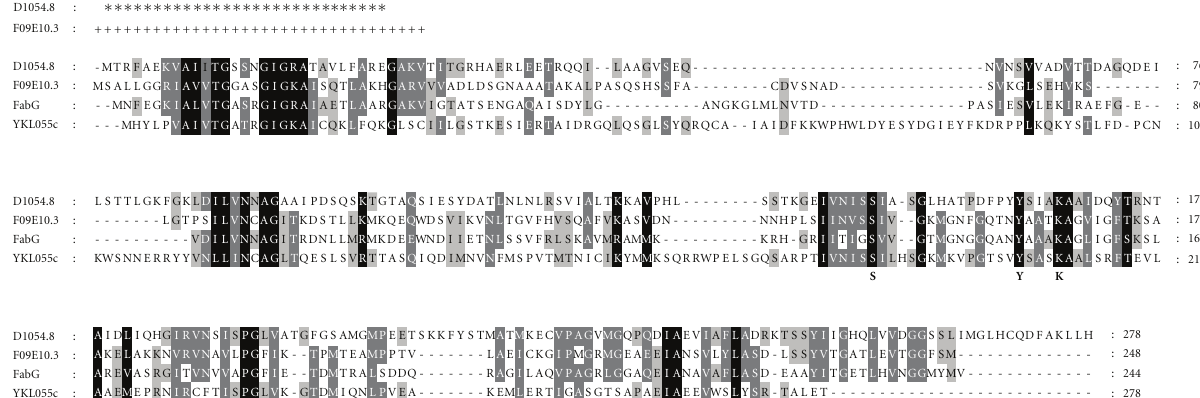
Figure 1: Similarity of the C. elegans D1054.8 and F09E10.3 gene products to their bacterial or yeast homologues, FabG and YKL055c (Oar1p), respectively. Comparison of the deduced amino acid sequences was undertaken using Multalin and Genedoc. Dashes indicate the arrangement of the sequences for best fit. Black shadings refer to strictly conserved amino acid residues among all four sequences whereas the darker and lighter grey shadings denote regions with more relaxed residue similarities not necessarily shared by the full set of sequences. MitoProt predictions of cleaved sequences are indicated (D1054.8, ∗ ; F09E1.03, +). The catalytic triad of FabG consisting of the amino acid residues serine 148 (S), tyrosine 151 (Y), and lysine 155 (K) are shown in bold below the sequences. Accession numbers used were FabG; AP 001719; D1054.8, CAA98438; F09E10.3, AAB52488; YKL055c,